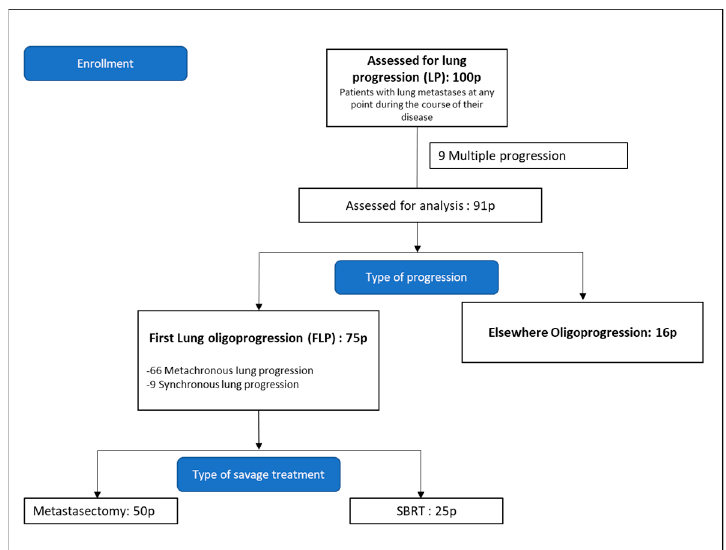
Figure 1. Consort diagram. Pathological confirmation of pulmonary metastases was not required. Informed consent was obtained prior to treatment (either surgery or